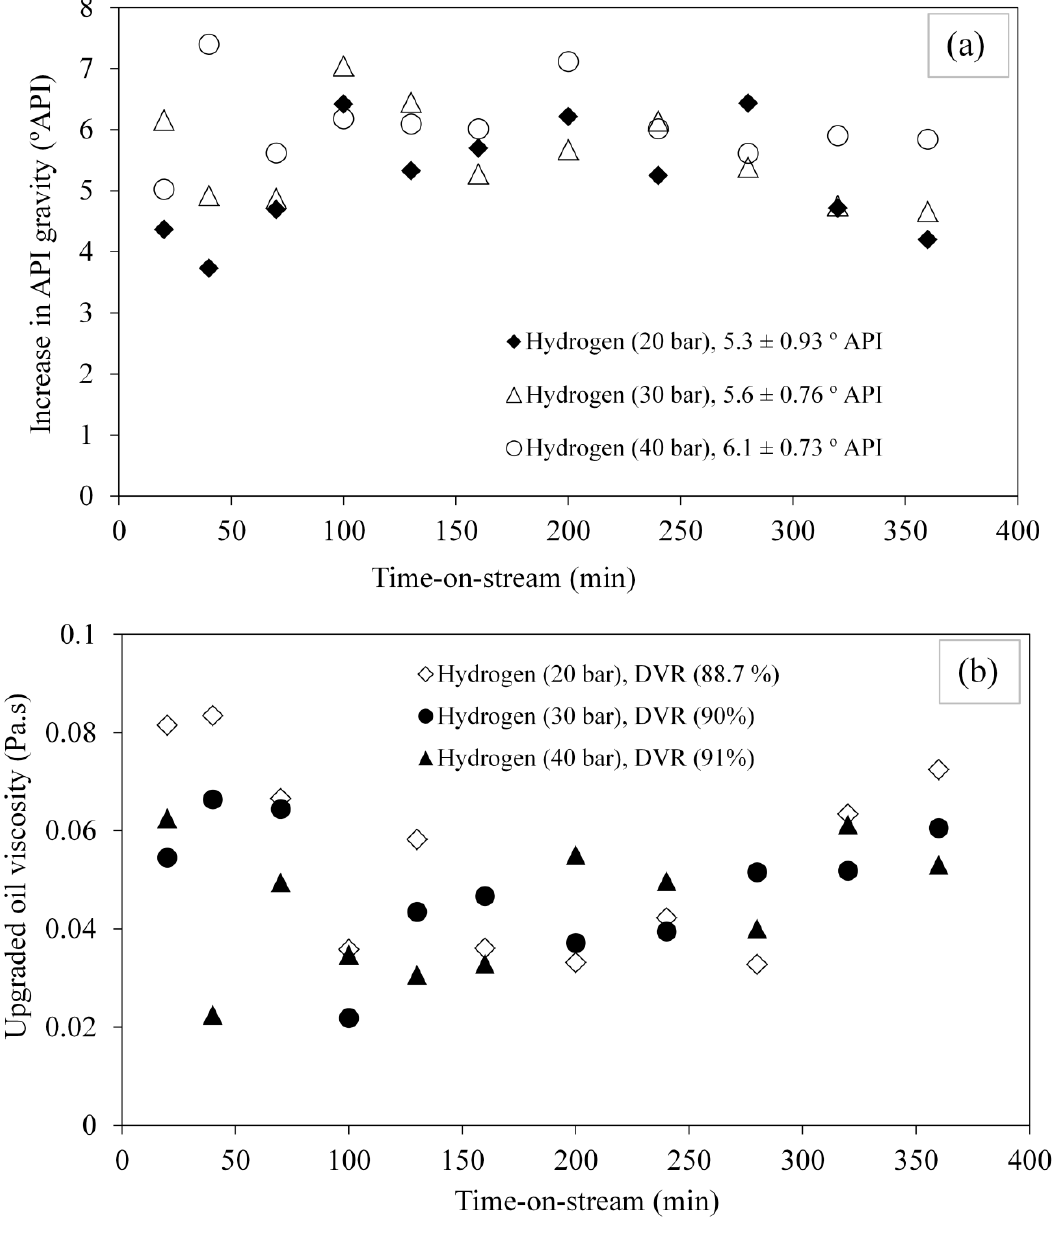
Figure 2. Effect of hydrogen pressure on ( a ) the upgraded oil API gravity and ( b ) the upgraded oil viscosity as a function of time ‐ on ‐ stream.